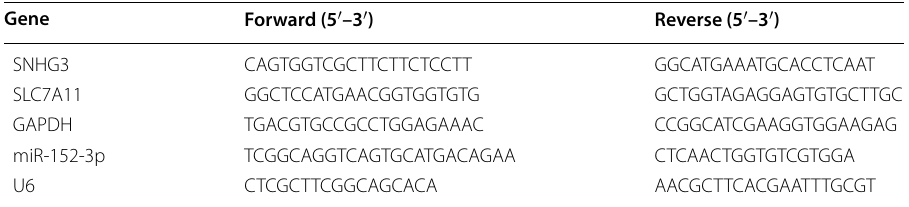
Table 1 Primer sequences in